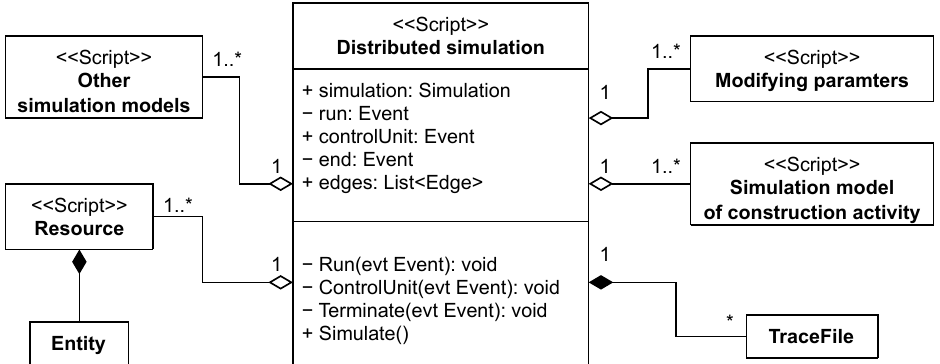
Figure 7. Class diagram of the distributed simulation component. This diagram uses standard UML notation: Hollow diamonds represent aggregation; filled diamonds represent composition; stars indicate multiplicity ( 1..* means that 1 or more instances of the child class are part of the parent class, * means that zero or more instances of the child class are part of the parent class).